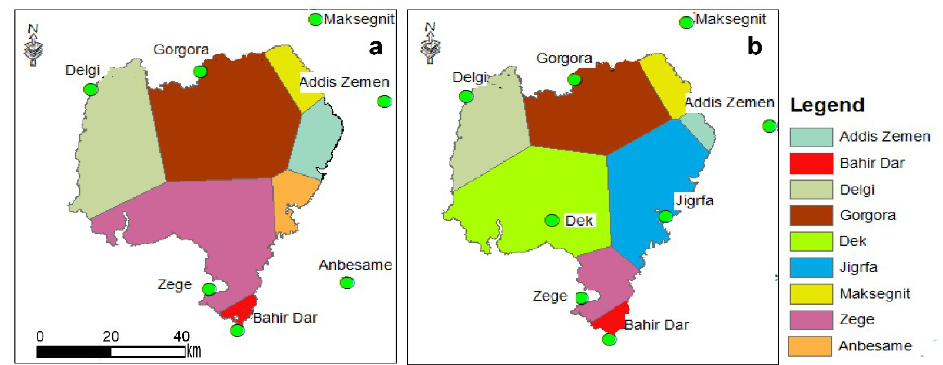
Figure 3. Thiessen polygon for rainfall stations around Lake Tana: ( a ) land‐based rainfall (seven land based stations, ( b ) lake + land‐based (six land stations and two lake stations—Dek Island and Jigrfa).